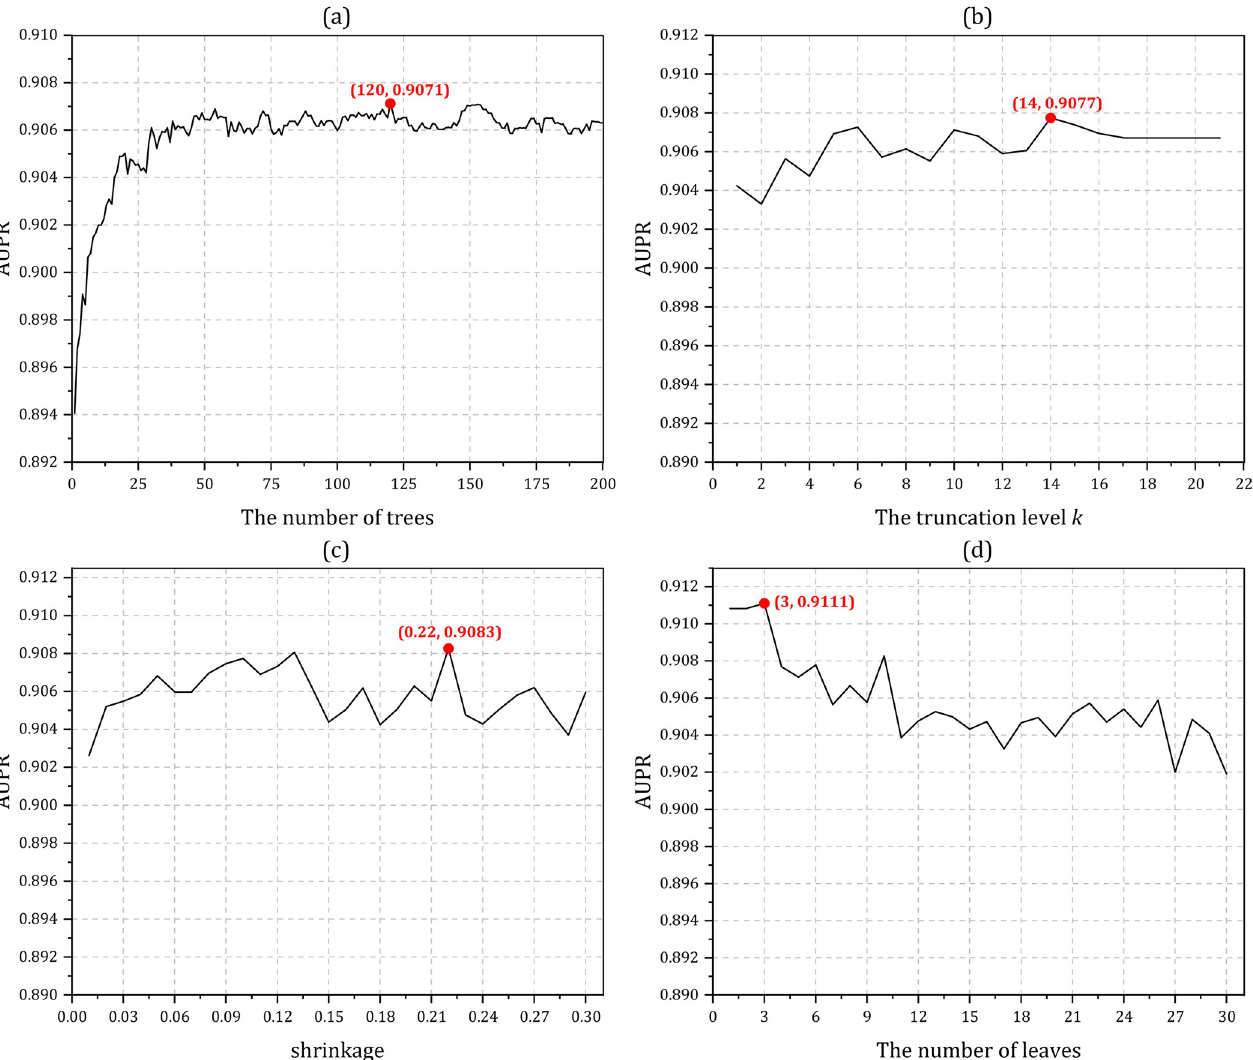
Fig 3. The predictive results of iPiDA-LTR predictor on S a dataset via five-fold cross-validation. (a) The truncation level k , shrinkage and the number of ben leaves are assigned as 10, 0.10, and 10 respectively, which are RankLib’s default values (https://sourceforge.net/p/lemur/wiki/RankLib/), and the optimal value of the number of trees is 120; (b) The number of trees, shrinkage and the number of leaves are fixed as 120, 0.10 and 10 respectively, and the truncation level k is optimized as 14; (c) The number of trees, the truncation level k and the number of leaves are fixed as 120, 14 and 10 respectively, and the shrinkage is optimized as 0.22; (d) The number of trees, the truncation level k and shrinkage are 120, 14 and 0.22 respectively, and the number of leaves is set as